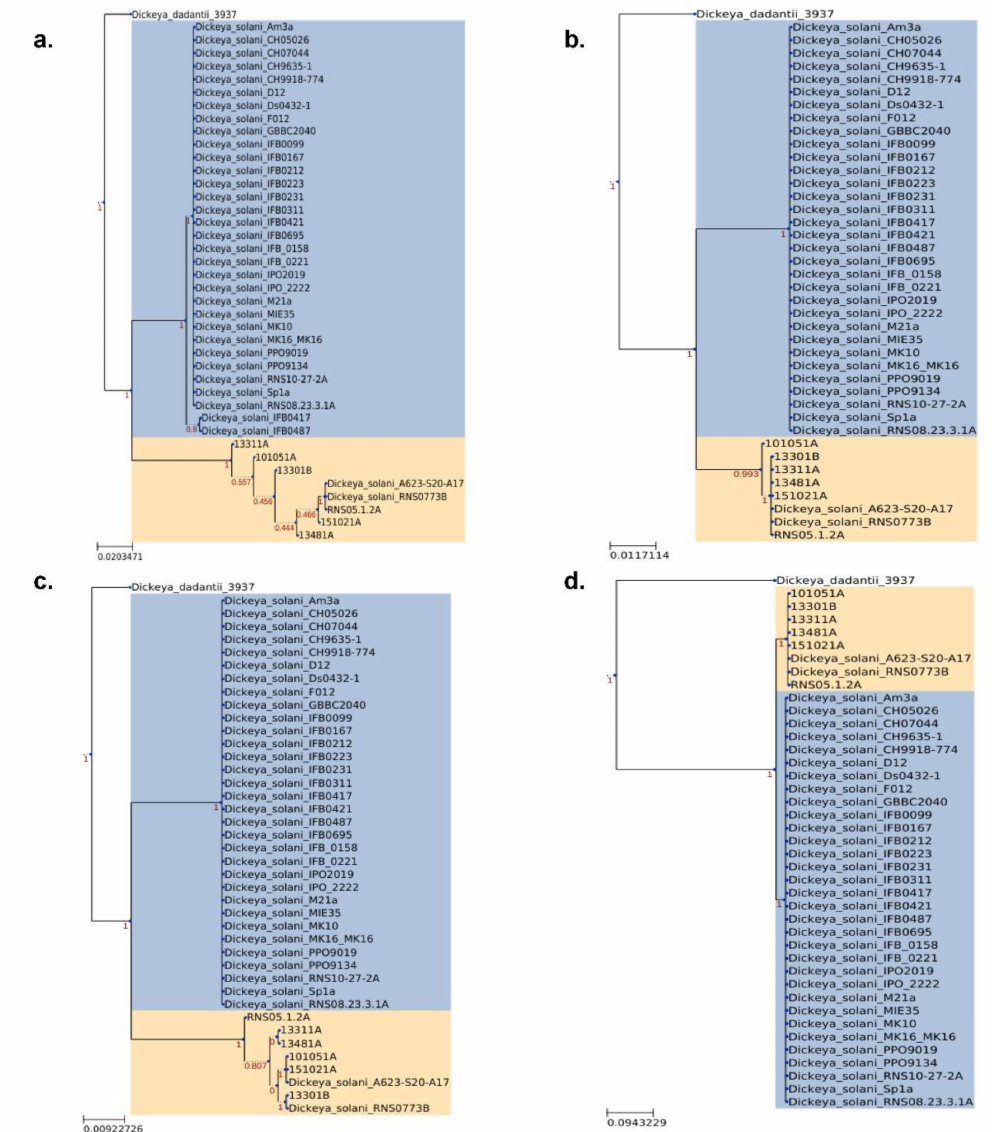
Figure 5. Phylogenetic analysis of four regions highlighting high variant densities. In ( a – d ) are, respectively, regions 1, 2, 3 and 4 with 42, 30, 28 and 21 variants/kbp. The bootstrap values are indicated in red. D. dadantii 3937 sequence was used as an